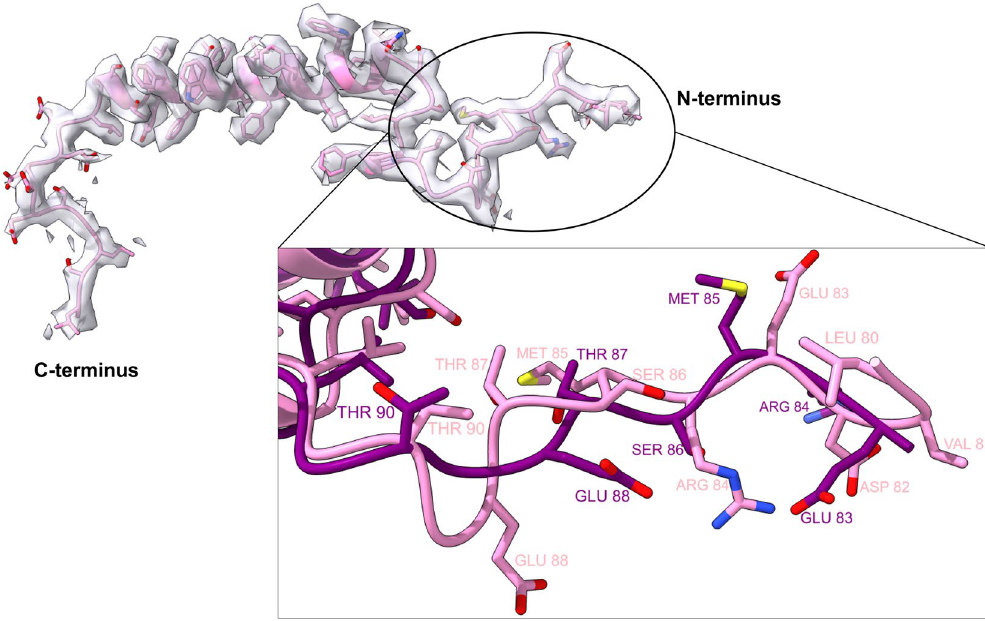
Figure 3. The low molecular weight protein PsbW fit into its respective density. Inset: Dissimilar modelling of the N-terminus of PsbW between 7OUI (pink) and 5MDX (purple) Arabidopsis PSII